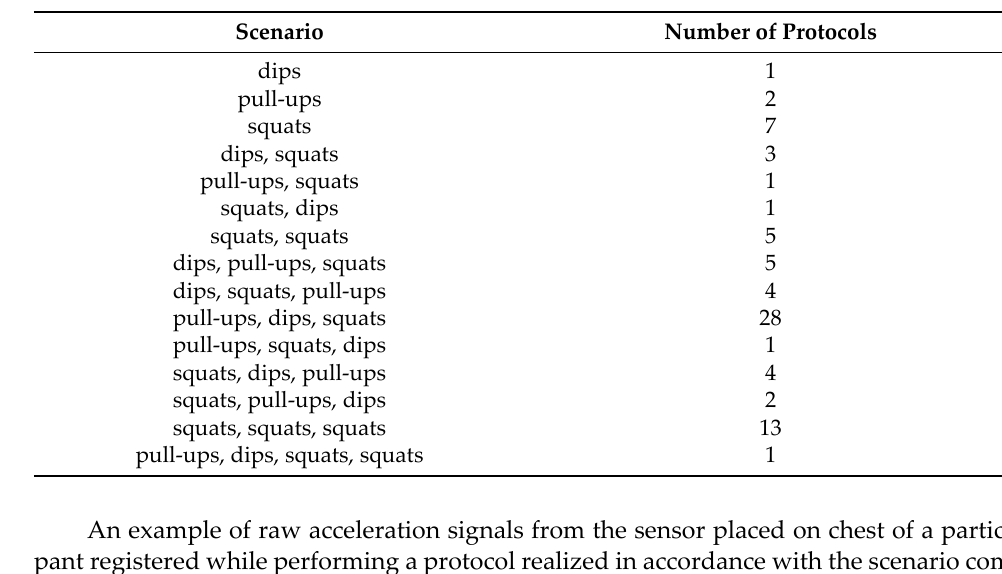
Table 2. The used scenarios and the number of protocols.